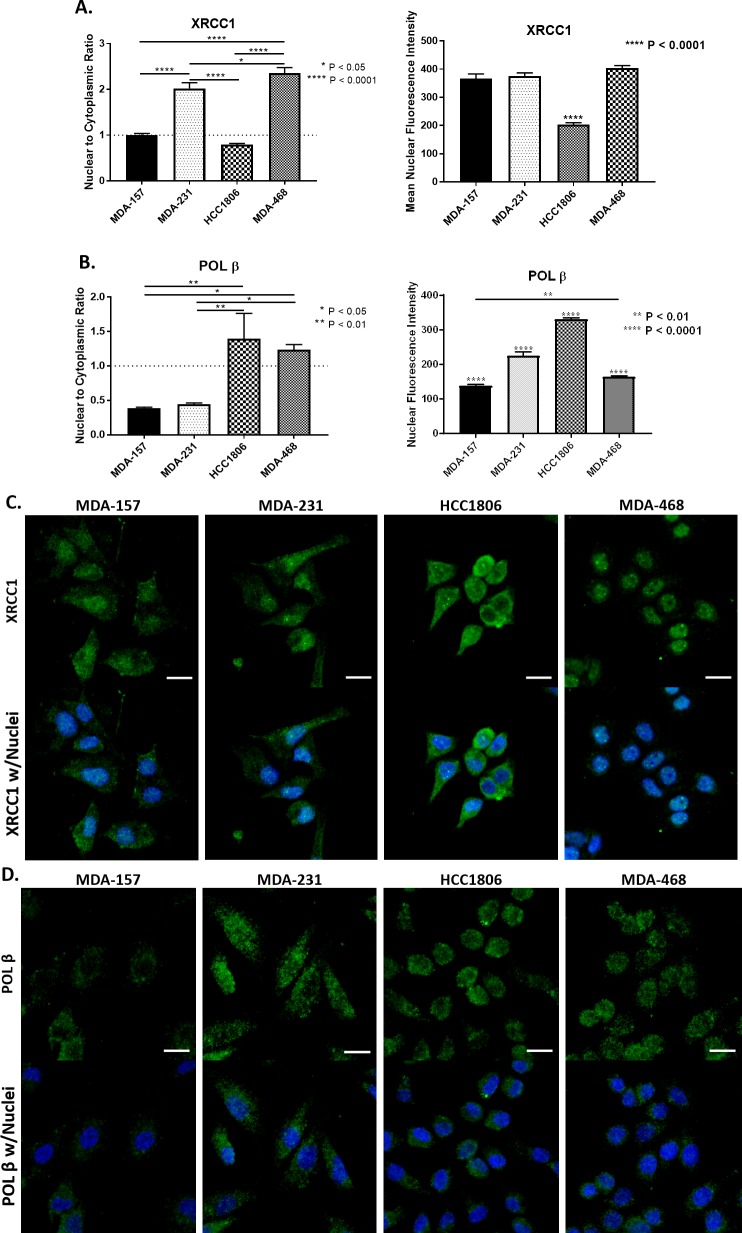
Subcellular localization and quantification of BER proteins.A) Left, XRCC1 nuclear to cytoplasmic ratio (N/C) is reported as 1 representing equal distribution (MDA-157), > 1 representing nuclear localization (MDA-231 and MDA-468), and < 1 representing nuclear exclusion (HCC1806). (**** P < 0.0001, MDA-157 to MDA-231, MDA-157 to MDA-468, MDA-231 to HCC1806, HCC1806 to MDA-468; * P < 0.05, MDA-231 to MDA-468). Right, mean fluorescence intensity of XRCC1. (**** P < 0.0001, HCC1806 to MDA-157, MDA-231, and MDA-468) B) Left, N/C ratio of POL β. (** P < 0.01, MDA-157 to HCC1806, MDA-231 to HCC1806; * P < 0.05, MDA-157 to MDA-468, MDA-231 to MDA-468) Right, mean fluorescence intensity of POL β. (**** P < 0.0001, MDA-157 to MDA-231, MDA-157 to HCC1806, MDA-231 to HCC1806, MDA-231 to MDA-468, HCC1806 to MDA-468; ** P < 0.01, MDA-157 to MDA-468) C) Representative images of localization of XRCC1 in TNBC cell lines. D) Representative images of localization of POL β in TNBC cell lines. Scale bar = 20 μm.